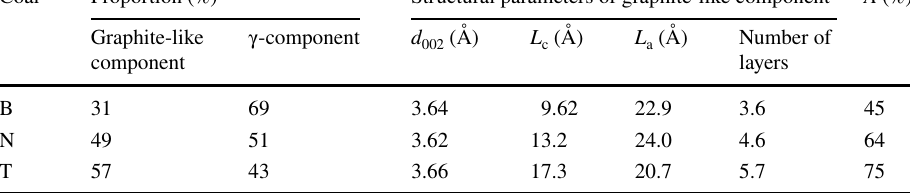
Table 4 The characterization of the spatial structure of